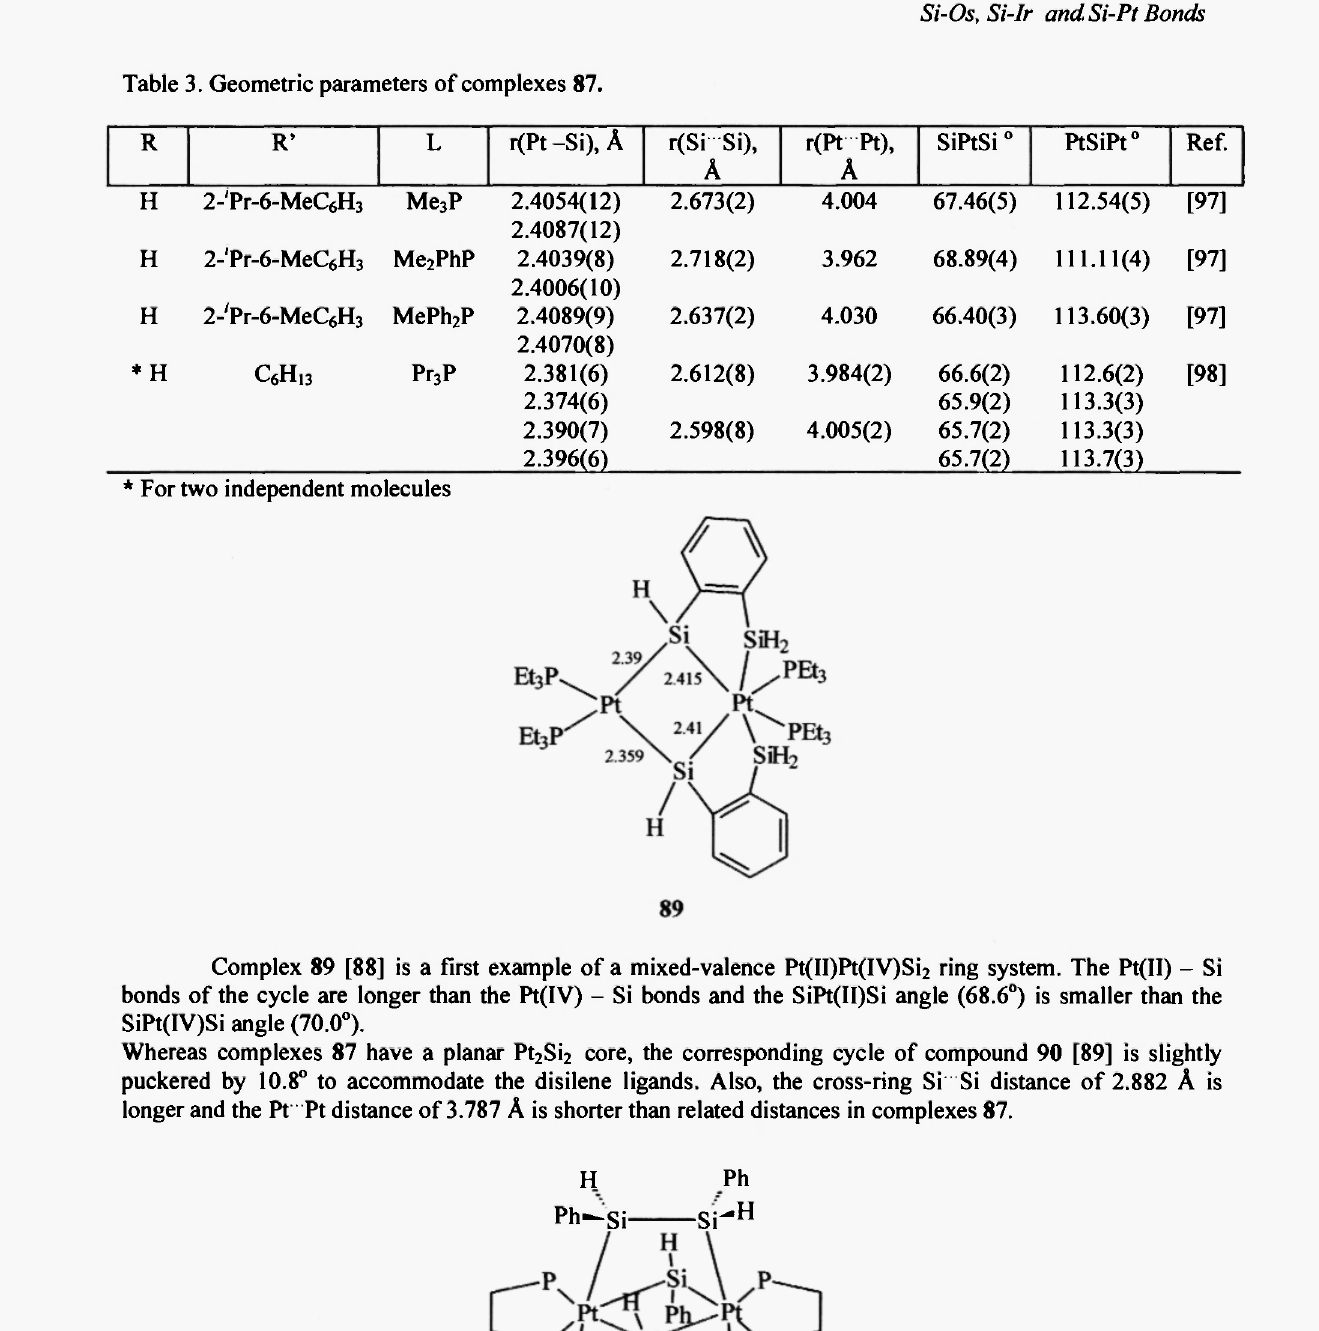
Table 3. Geometric parameters of complexes